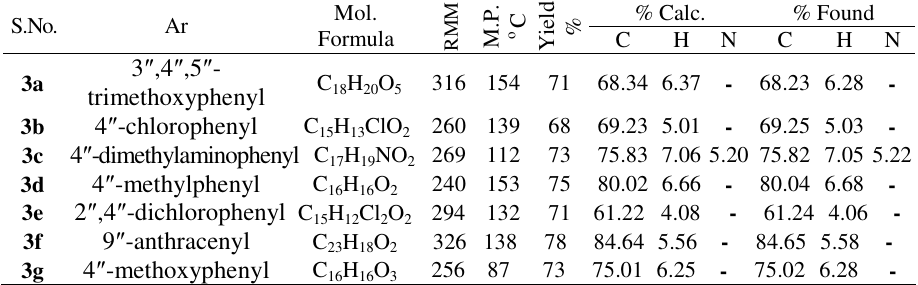
Table 1. Physical data of the prepared compounds 3 ( a-g )